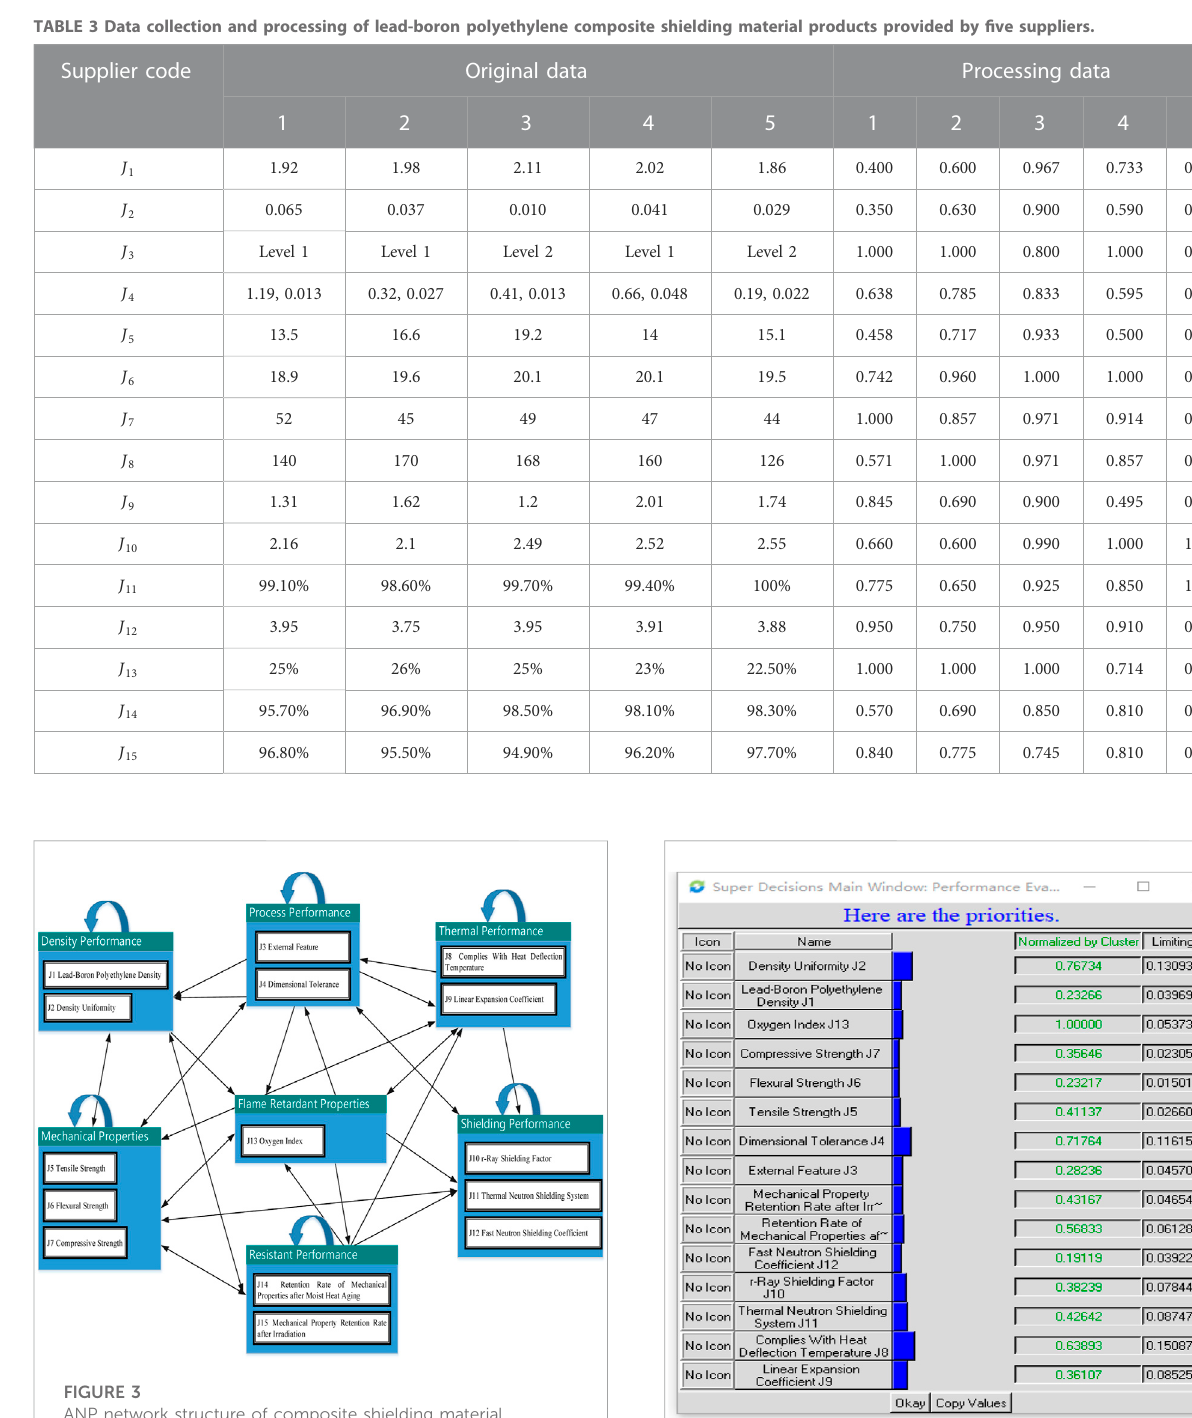
FIGURE 4 Priority level of indicators under limit super-matrix (centralized weight of